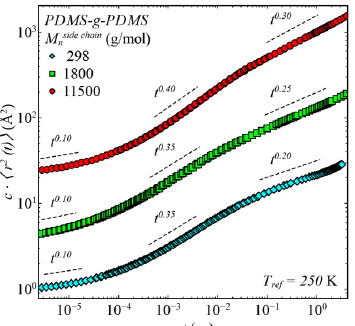
Fig. 15. Mean square displacement, ⟨𝑟 (cid:2870) (cid:4666)𝑡(cid:4667)⟩ , as a function of time, 𝑡 , for all three samples. Data has been previously published at Bichler et al